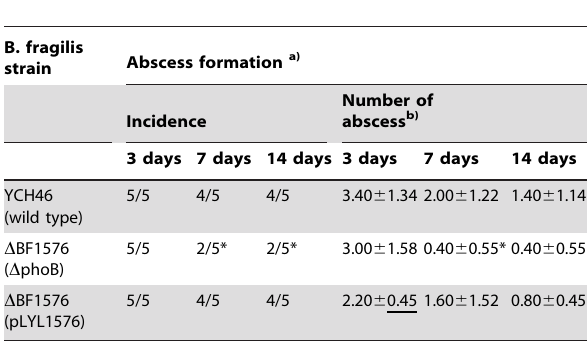
Table 3. Peritoneal abscess formation by B. fragilis strains.